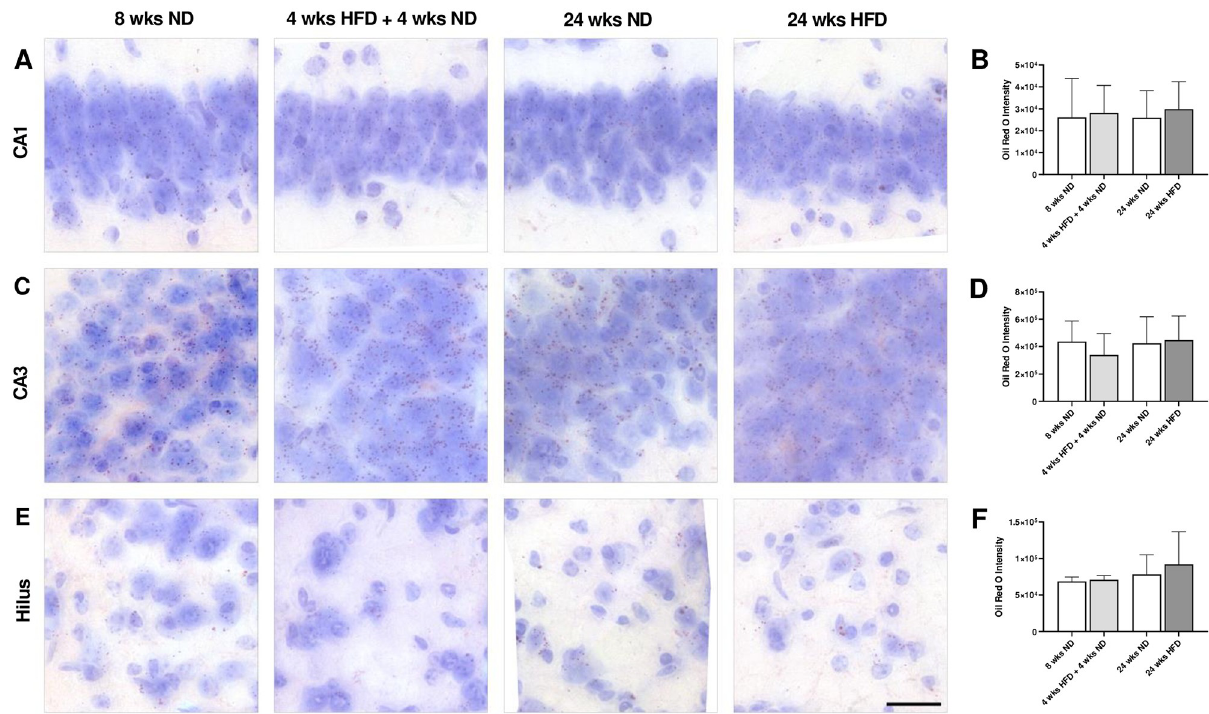
Fig 9. Long-term HFD does not lead to lipid droplet accumulation and histological changes in the hippocampus. (A, C, E) Representative photomicrographs showing Oil Red O stained CA1, CA3 and hilar regions of male wild-type C57BL/6J mice fed with ND for eight wks, HFD for four wks followed by ND for four wks, ND or rather HFD for 24 wks. (E) Scale bar corresponds to 25 μ m. Graphs display (B) Oil Red O intensity in CA1, (D) CA3 and (F) hilar regions. Dietary lipids do not accumulate within the hippocampus due to HFD. Data are presented as mean values and error bars indicate SD; 8 wks ND n = 4–5, 4 wks HFD + 4 wks ND n = 5–6, 24 wks ND n = 6, 24 wks HFD n = 6.